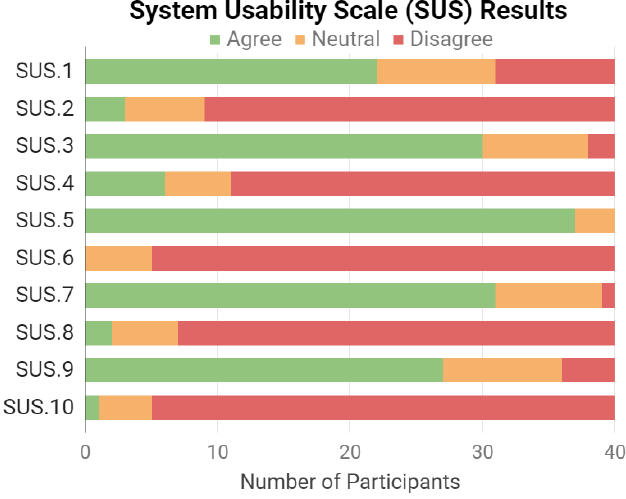
Figure 11. Summary of the answers obtained in the SUS questionnaire. In sentences 1, 3, 5, 7, and 9 it’s considered a positive feedback when users agree to the statement, while sentences 2, 4, 6, 8 and 10 it’s considered a positive feedback when users disagree. The complete sentences and percentages can be observed in Table III in the